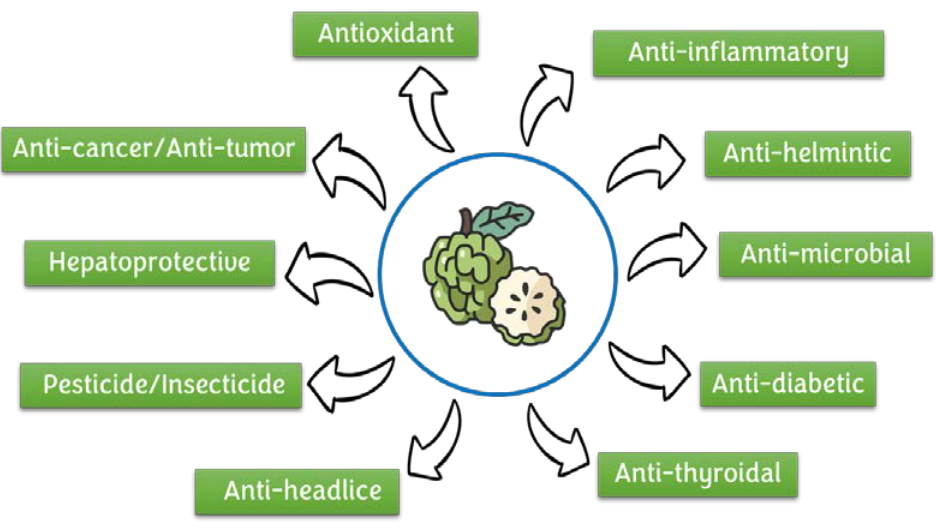
Figure 4. Biological properties of Annona squamosa seeds.